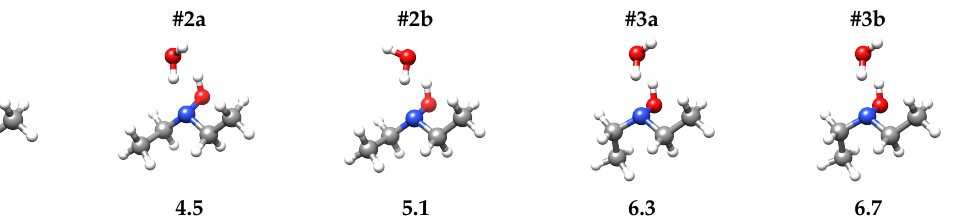
Figure 2. Sketch and zero-point corrected relative energy values ( ∆ E 0 [kJ · mol − 1 ]) of DEHA-W conformers.